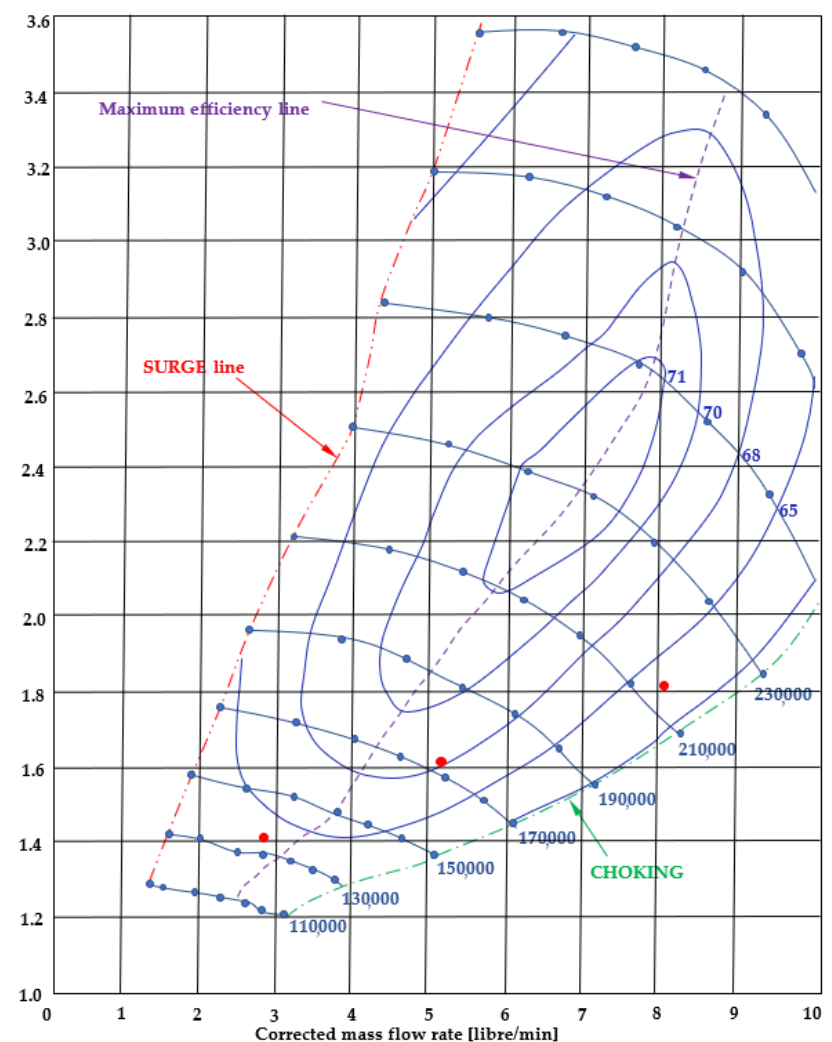
Figure 1. Operative radial compressor map and actual operating points in function of ICE rpms. Table 2. Compressor operating points at different ICE engine rotational speeds.